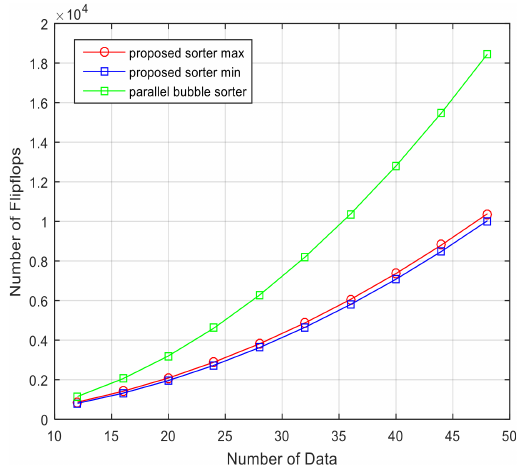
Figure 12. Comparison of the number of registers used according to the number of data of the received signal between the proposed sorter and general bubble sorter (input data length = 16).